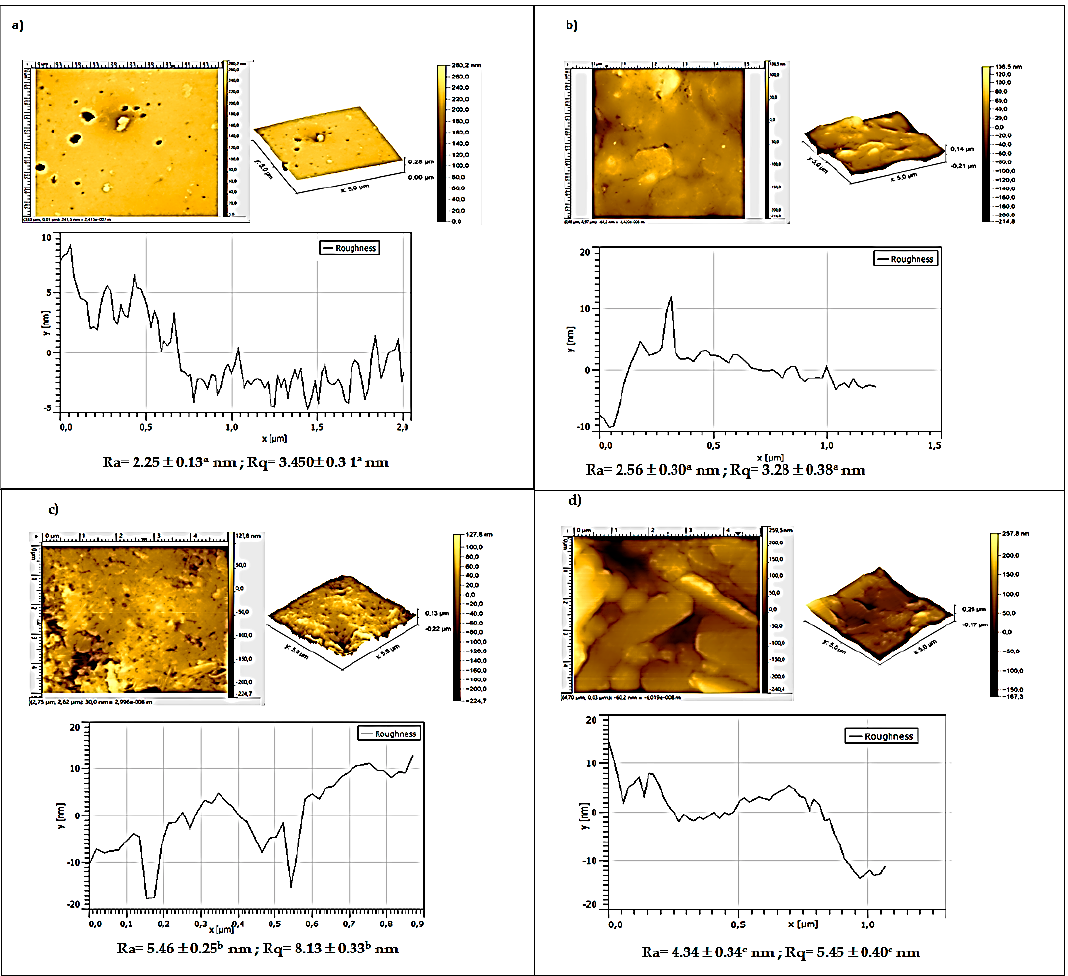
Figure 3. Atomic force microscopy (AFM) micrographs of chitosan-quinoa protein edible films. ( a ) QW; ( b ) QW + TG; ( c ) CT:QW (1:10, w / w ); ( d ) CT:QW (1:10, w / w ) + TG.